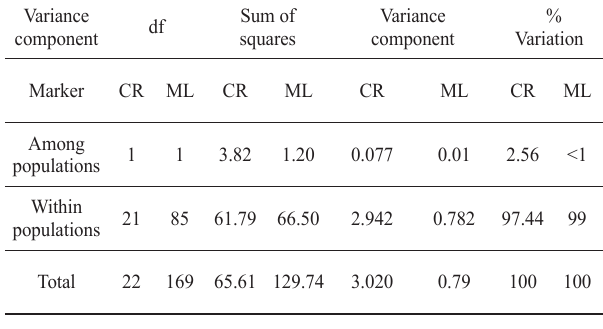
Table 1. Analysis of Molecular Variance (AMOVA) of Pagrus pagrus from the Buenos Aires coast to the partial sequence of the mitochondrial DNA control region (CR) and two microsatellite loci (ML). df =degree of freedom.